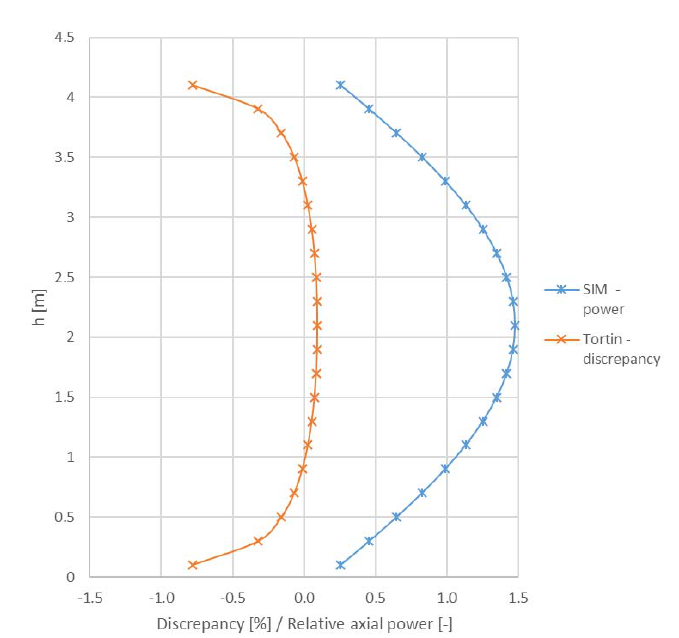
Figure 4. Axial power discrepancy for EPR core between Tortin and SIMULATE5.